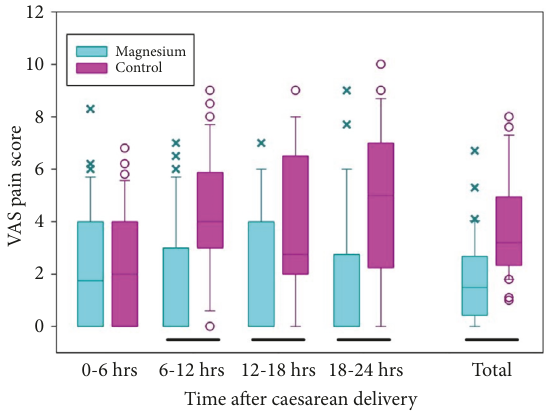
Figure2:Averagepainscoresinthemagnesiumandcontrolgroups. Box shows the interquartile range, horizontal line within box shows median, whiskers show 10/90th percentiles, x and o show points outside of the 10/90th percentiles. Solid bar beneath pairs of groups indicates a significant difference between the groups (p < 0.05).